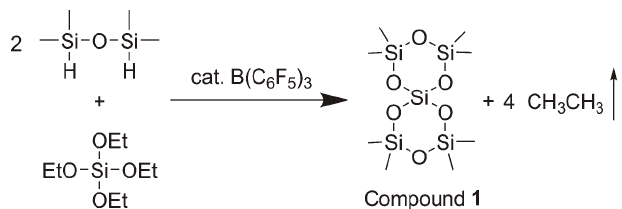
Figure 5. Synthesis of small molecule cyclic siloxane by the PR reaction [31]. Reproduced with the copyright permission.